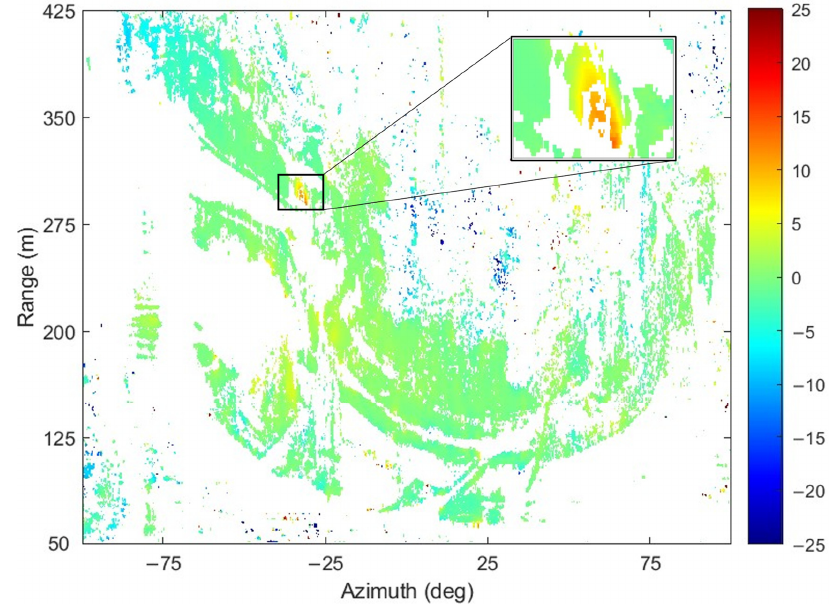
Figure 7. Average deformation rate on 3 April 2021.